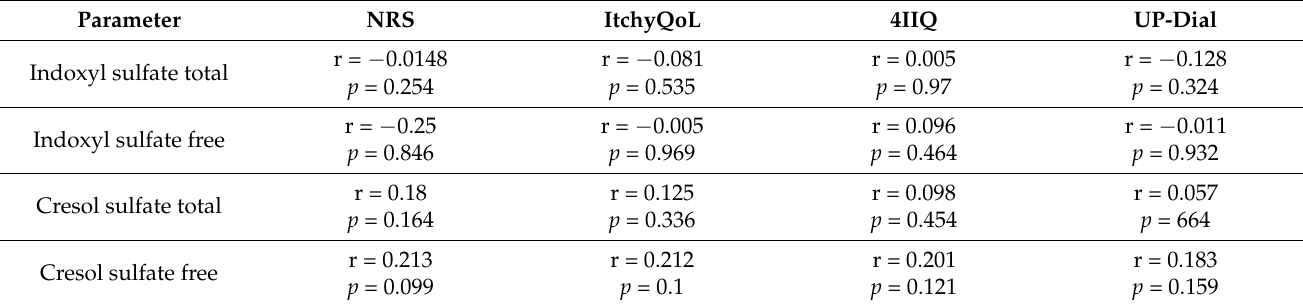
Table 3. Relationship between the serum level of PBUT and total scores of itch